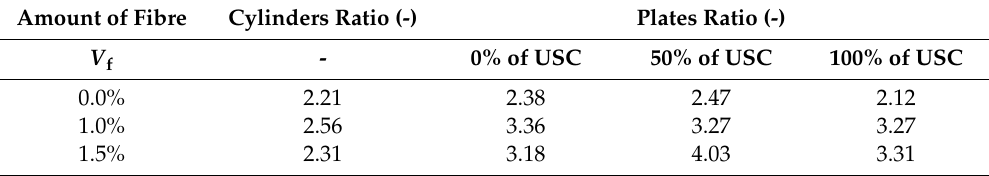
Table 5. Mean correction ratio of surface and bulk